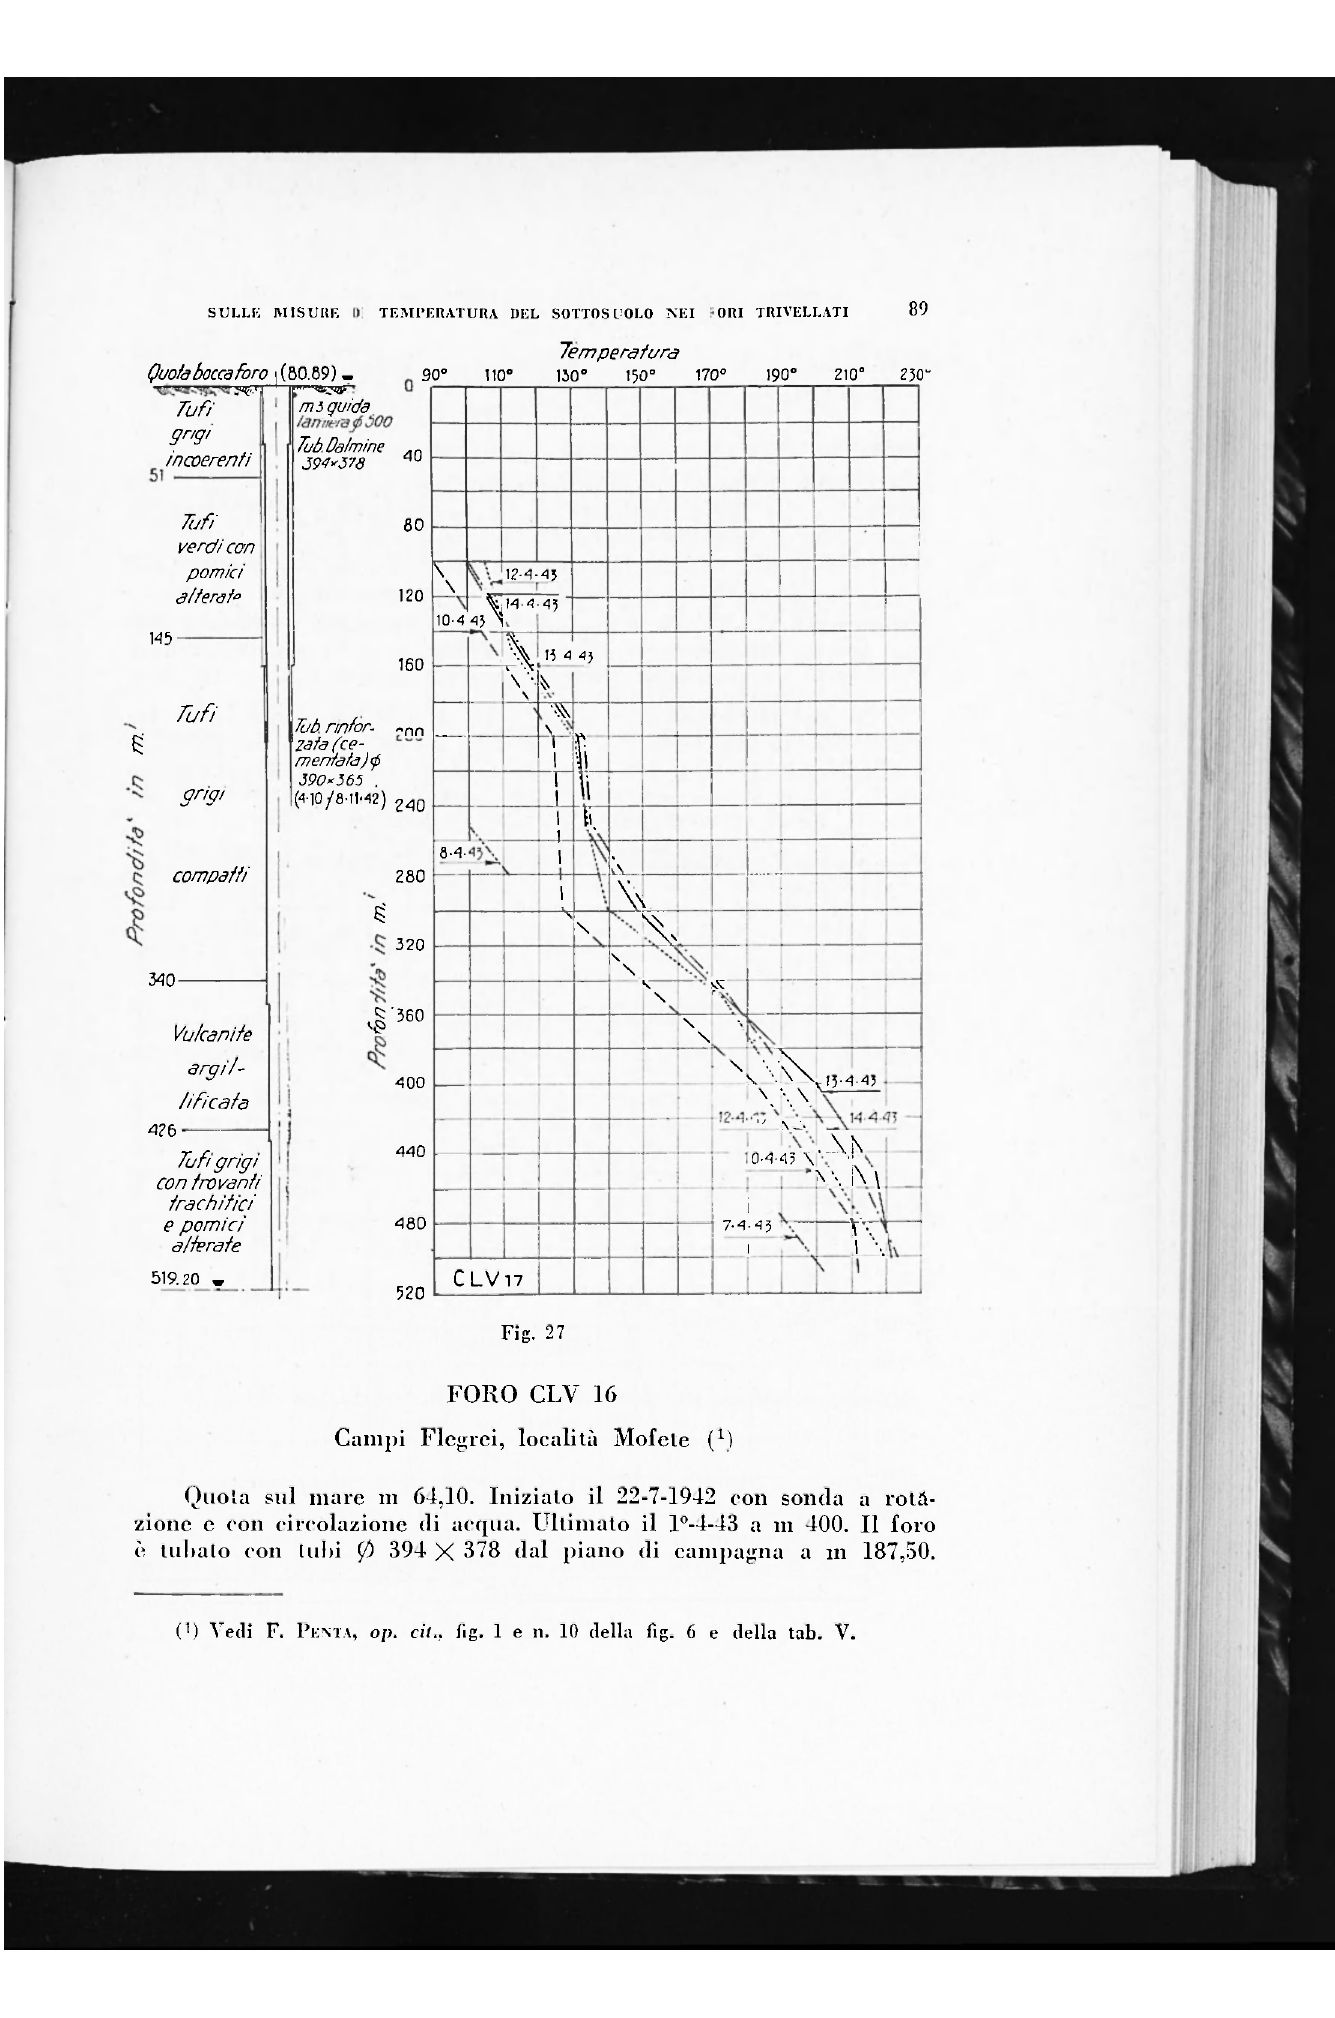
FORO CLV 16 Campi Flegrei, località Mofele ( 1